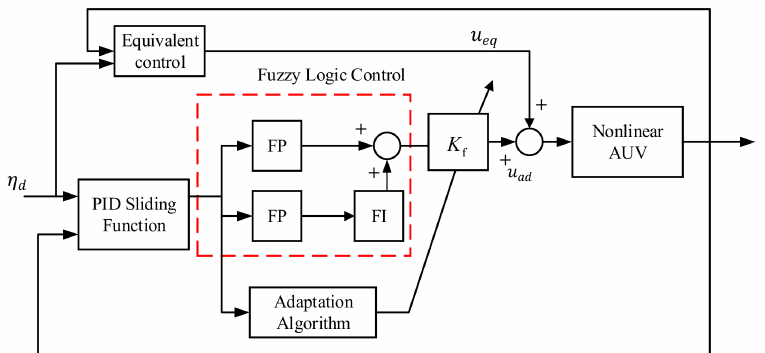
Figure 6. Block diagram of AFPISMC (Reprinted from reference [95] with permission from Springer- Verlag Berlin Heidelberg, copyright 2017).